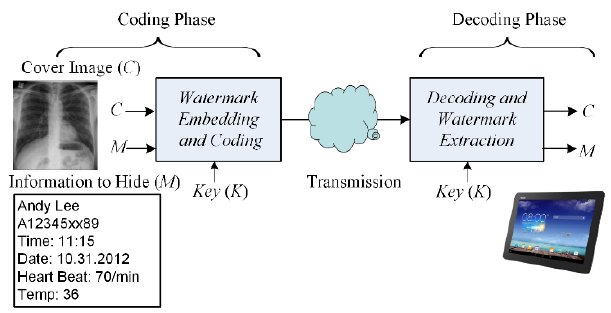
Fig. 1. General structure of the proposed reversible watermarking for